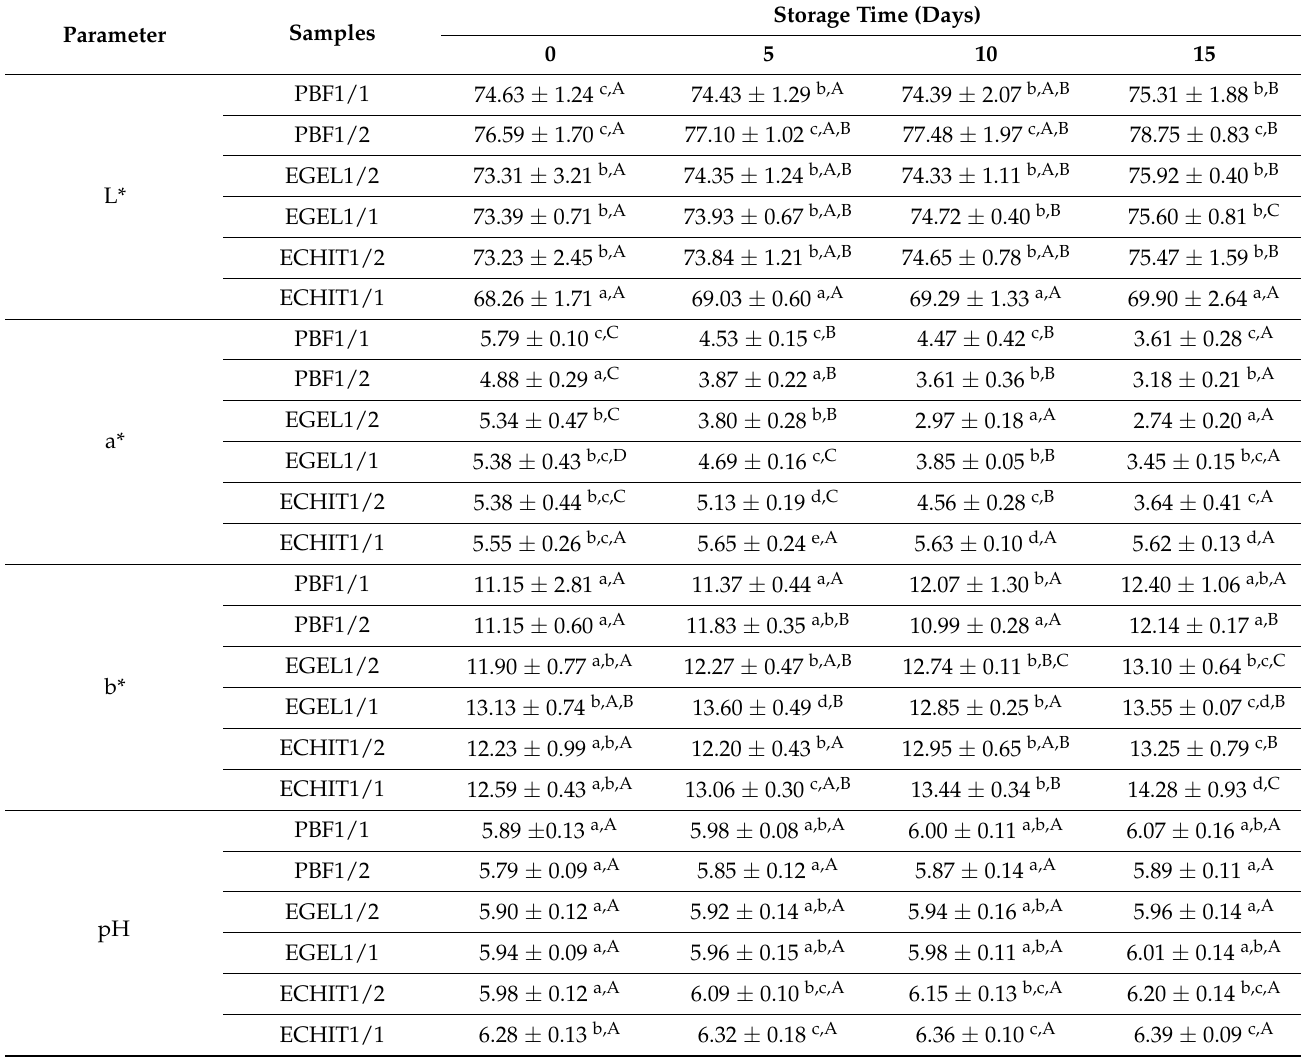
Table 6. Color parameters (L*—lightness, a*—redness and b*—yellowness) and pH of control and reformulated pork patties at 0, 5, 10 and 15 days of storage at 4 ◦ C